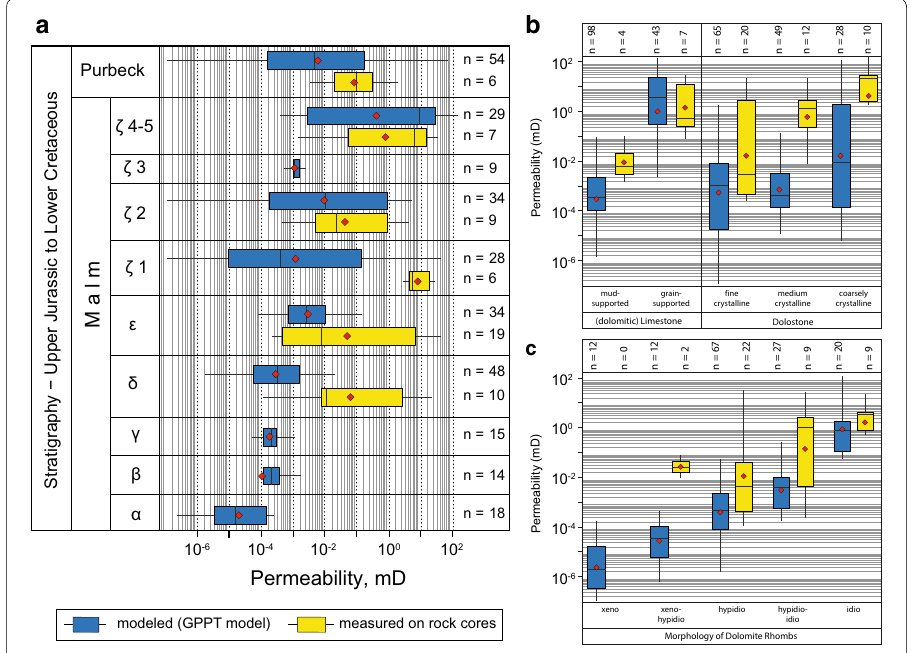
Fig. 13 Distribution of permeability measured on rock cores compared to permeability modeled by the GPPT. a Distribution within the stratigraphic units of the Malm reservoir. b Dependence of permeability on particle and crystal size as well as on the morphology of dolomite crystals ( c